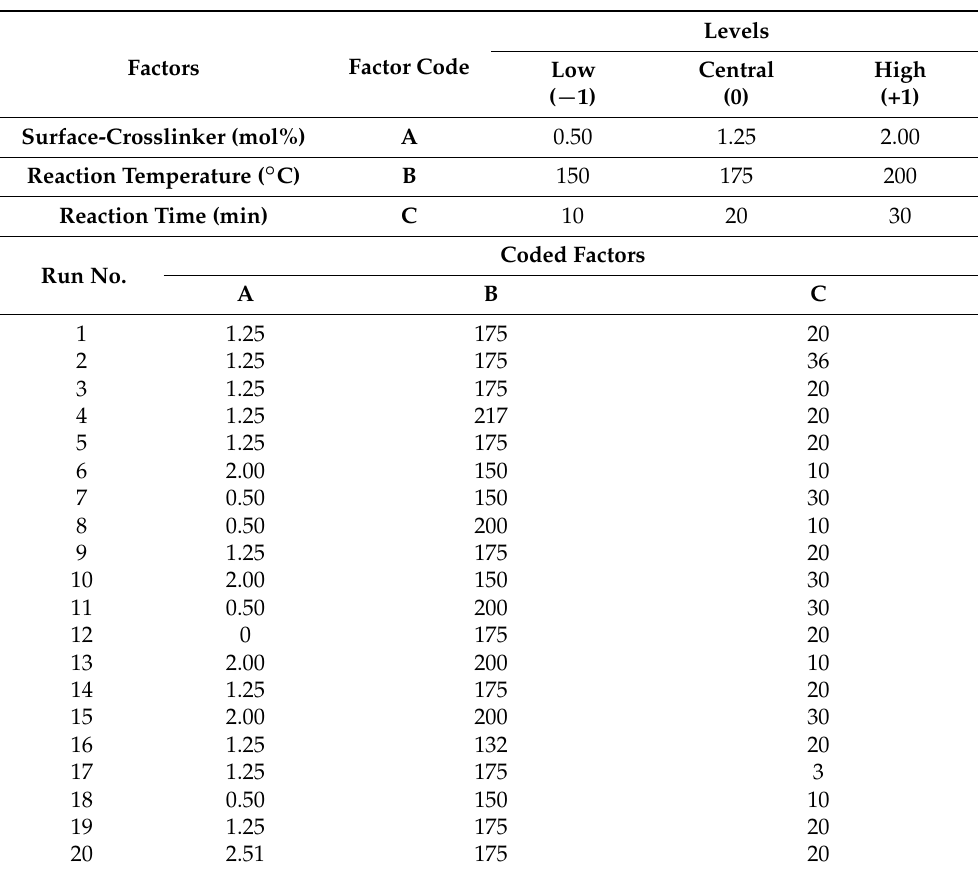
Table 1. Experimental factors and levels in the CCD. Factors Factor Code